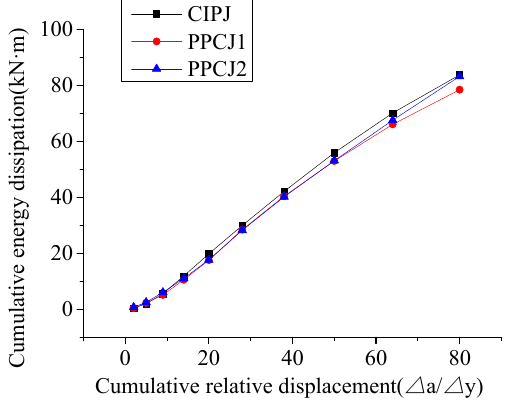
Figure 23. Relationship between cumulative energy dissipation and cumulative relative displacement of the joint left beam.